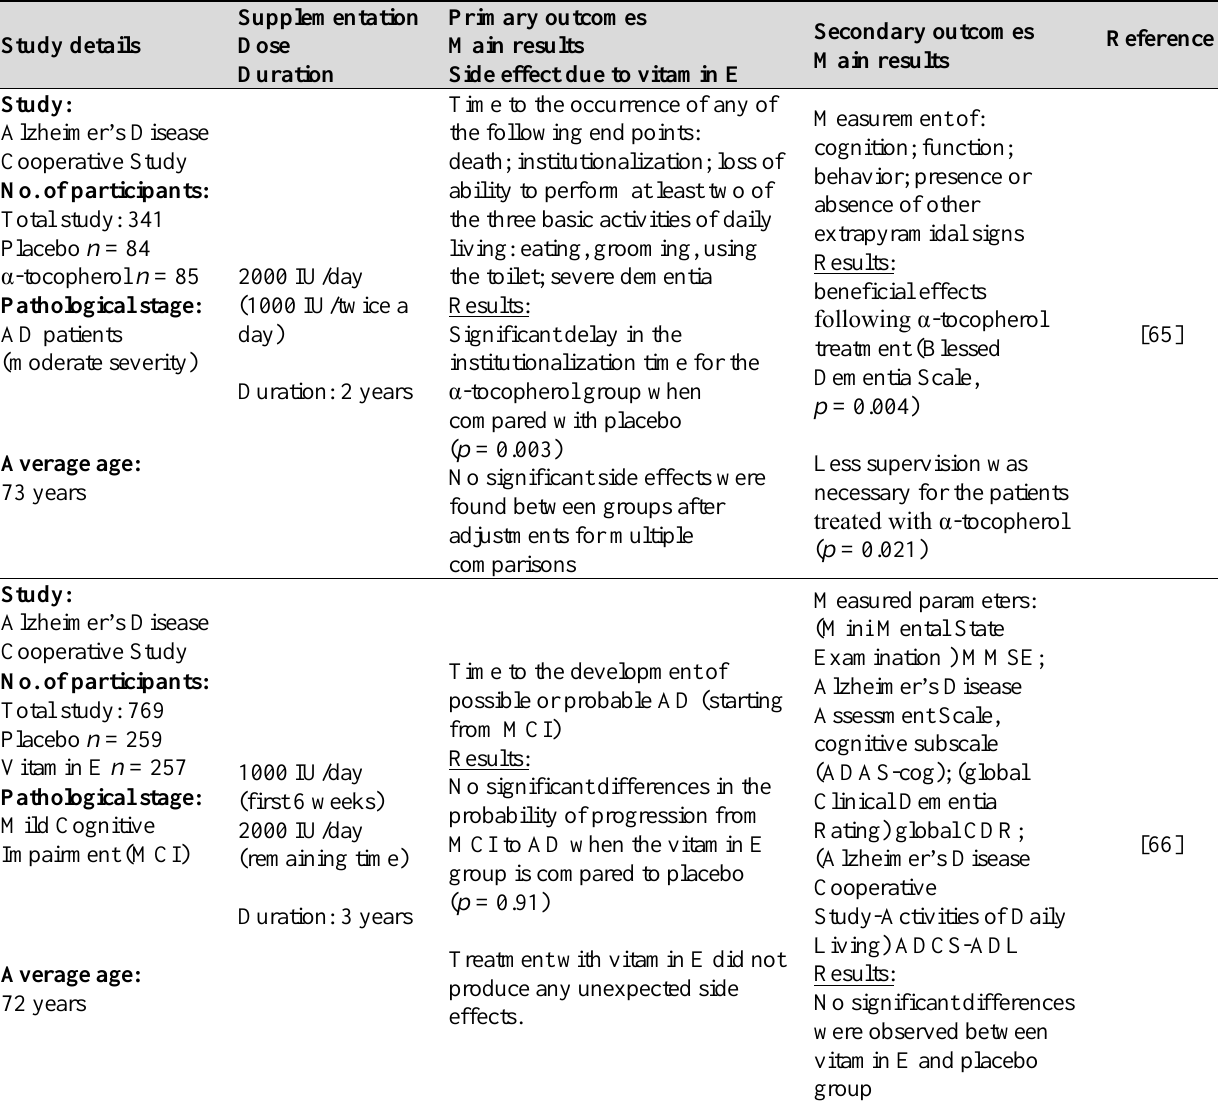
Table 1. Overview of clinical trials supporting vitamin E supplementation in individuals with